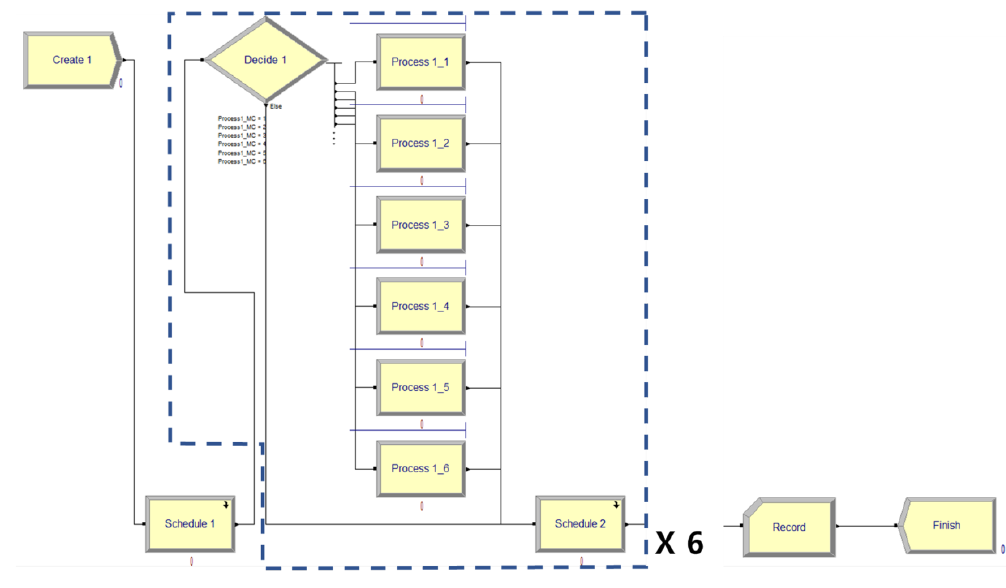
Figure 7. A simulation model with Arena.